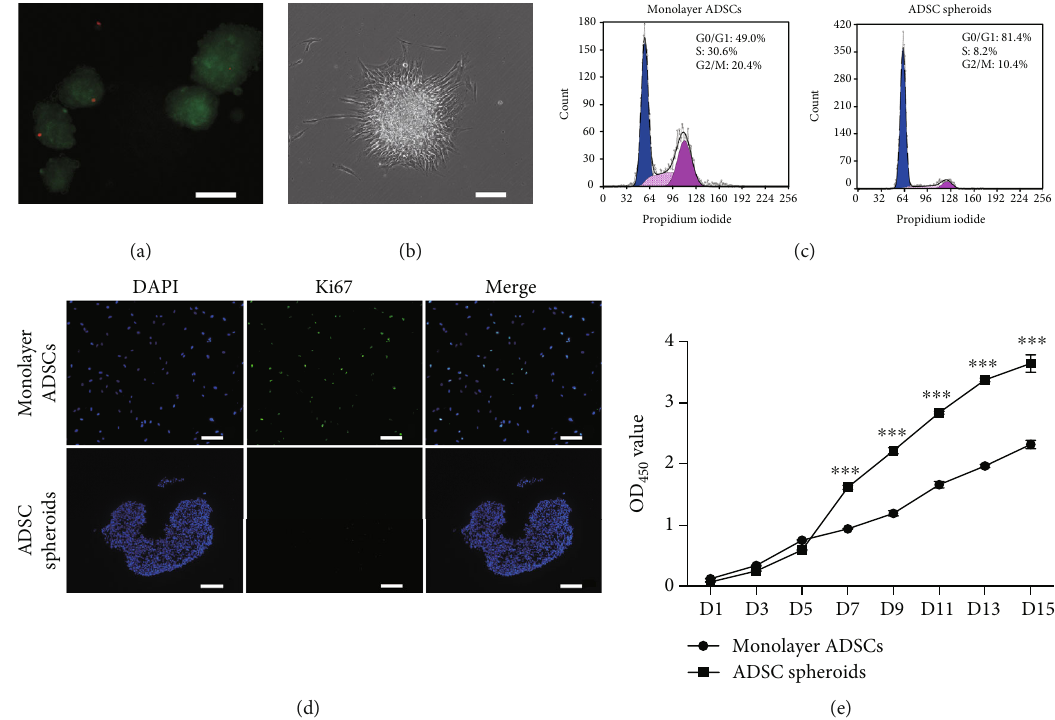
Figure 3: The viability and proliferative capacity of ADSC spheroids. (a) Fluorescence microscopic images of live/dead staining on day 4 postculture. Live cells within spheroids were stained with calcein AM (green), and dead cells were stained with PI (red). Scale bar: 100 μ m. (b) Morphology of ADSC spheroids after replacing TeSR-E8 with serum-containing medium. Scale bar: 150 μ m. (c) Cell cycle analysis via fl ow cytometry of monolayer ADSCs and ADSC spheroids. (d) Representative immunostaining of proliferation marker Ki67 in spheroid and monolayer ADSC after 4 days of culture. All nuclei were stained with DAPI (blue). Scale bar: 150 μ m. (e) Cell proliferation analysis using the CCK-8 assay. Data are displayed as mean ± SEM . ∗∗∗ P < 0 : 001 vs. monolayer